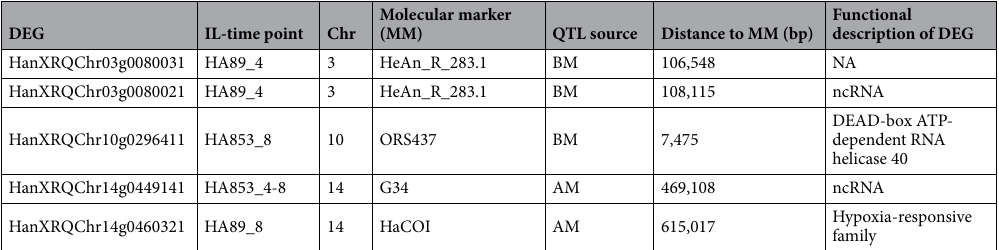
Molecular marker (MM) QTL source Distance to MM (bp)